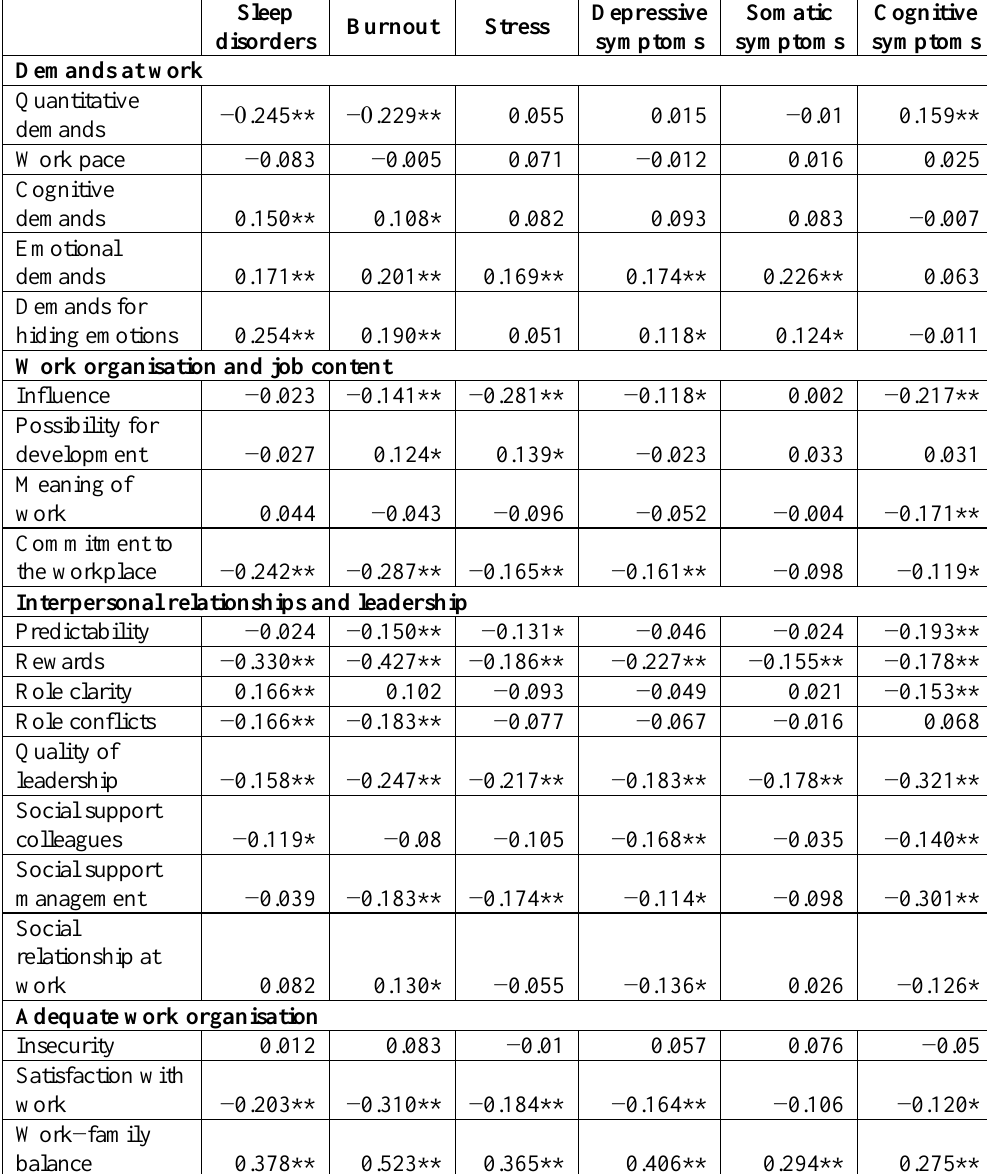
Table 3. Pearson’s r correlation for psychosocial factors and mental